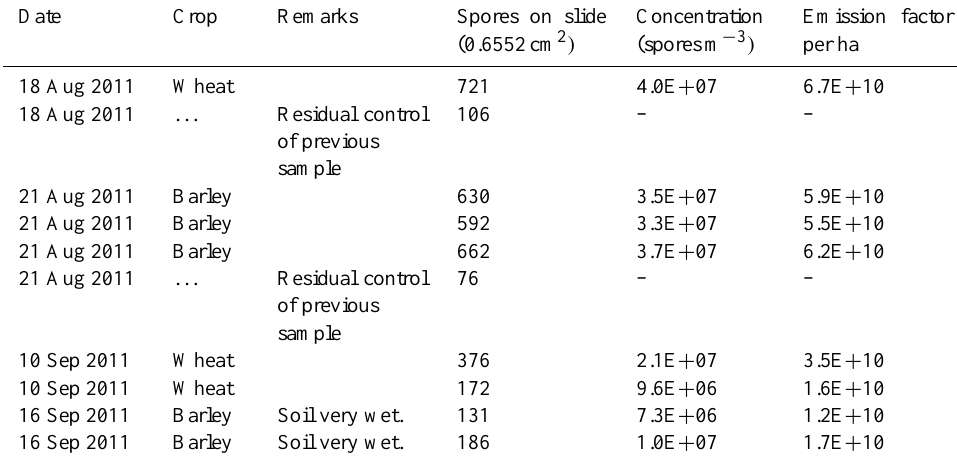
Table A1. Observed Alternaria spores in grab samples from the harvesting machine, the calculated concentration of sporesm − 3 in the exhaust air and the corresponding emission factor from harvested